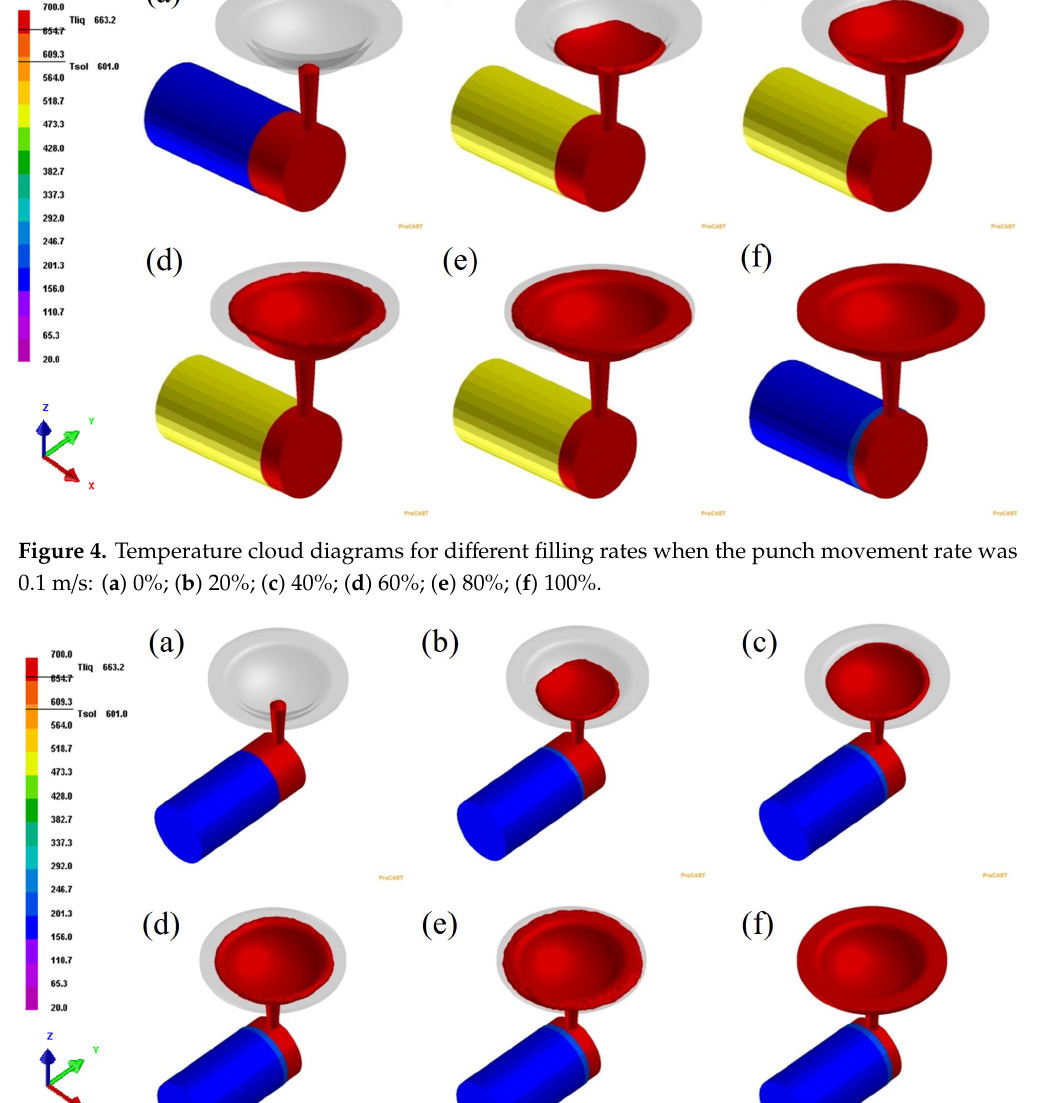
Figure 5. Temperature cloud diagrams for different filling rates when the punch movement rate was 0.08 m/s: ( a ) 0%; ( b ) 20%; ( c ) 40%; ( d ) 60%; ( e ) 80%; ( f ) 100%.